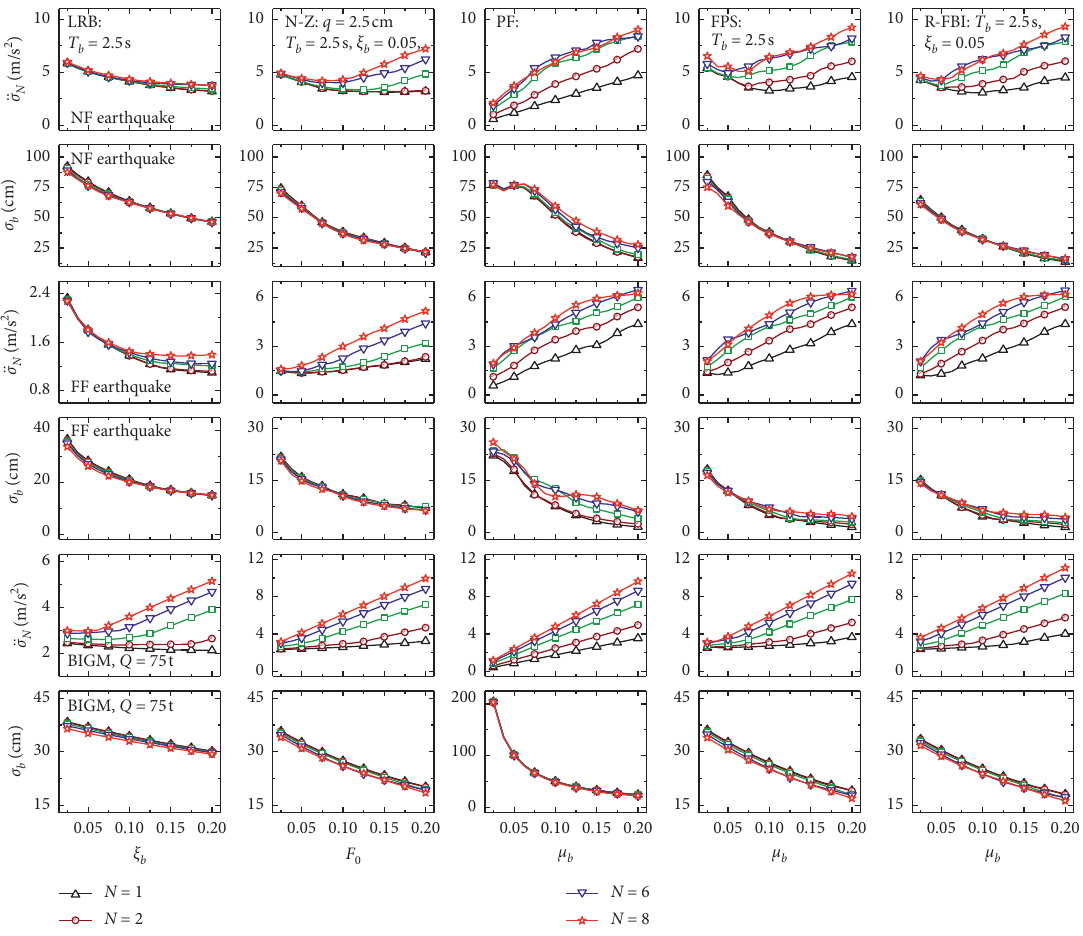
Figure 14: The effect of the number of stories on the top floor acceleration and isolator displacement of base-isolated buildings under NF earthquake, FF earthquake, and